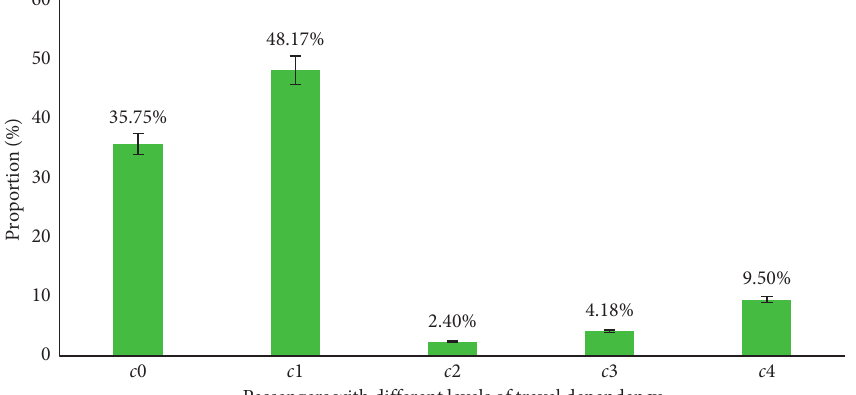
Figure 3: The overall proportion distribution of passengers in different dependency levels.